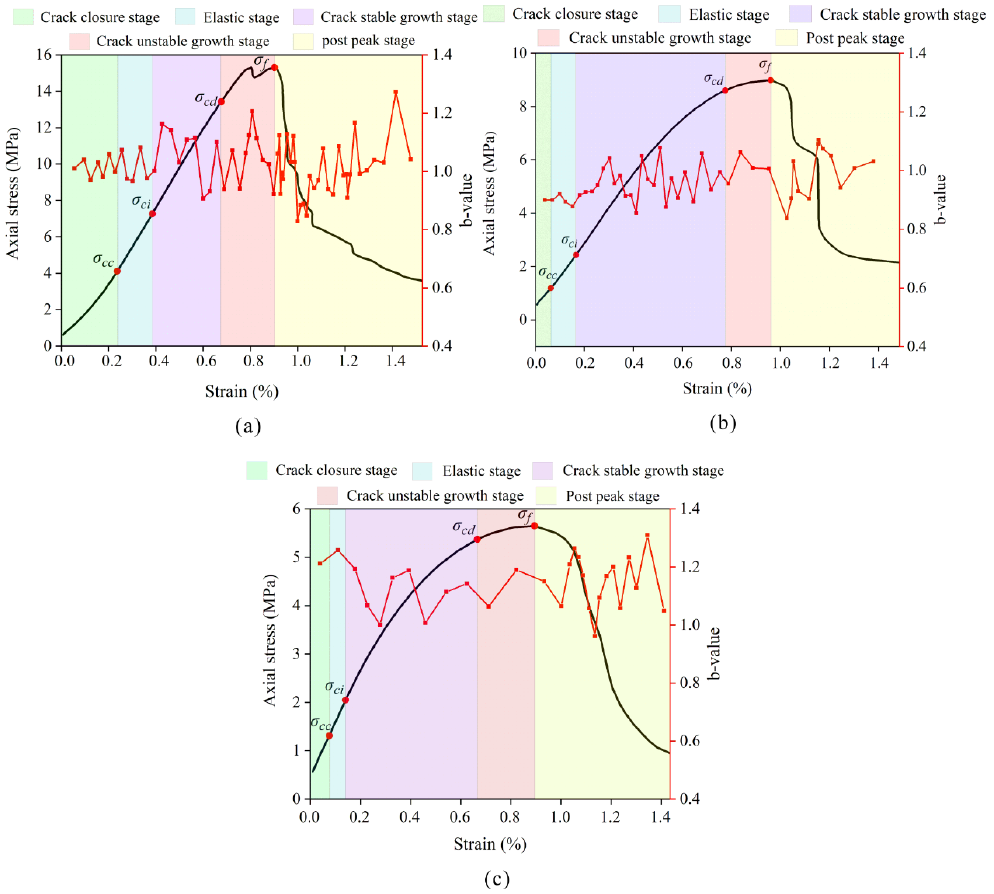
Figure 14. Relationship between the stress, the b value, and the strain for brittleness indexes of ( a ) 4.16, ( b ) 3.36, and ( c ) 2.25. ( a ) 4.16, ( b ) 3.36, and ( c ) 2.25.